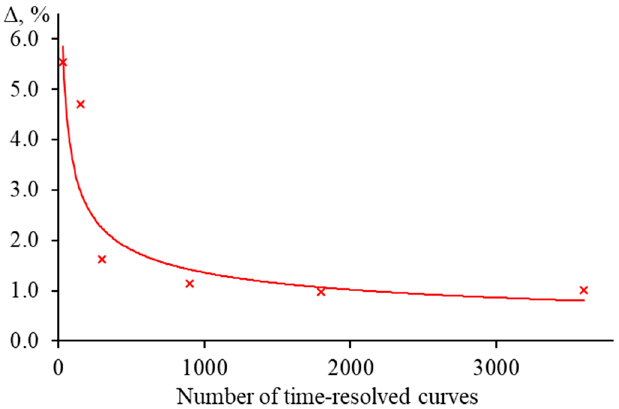
Figure 22. Change in the measurement error of the characteristic time from the number of averaged transient curves on the example of a solution of Sudan I in ethanol (0.1 µmol/L); middle-focused configuration ( 𝜔 (cid:3032)(cid:2868) = 42 µm, Figure 2, Table 3).